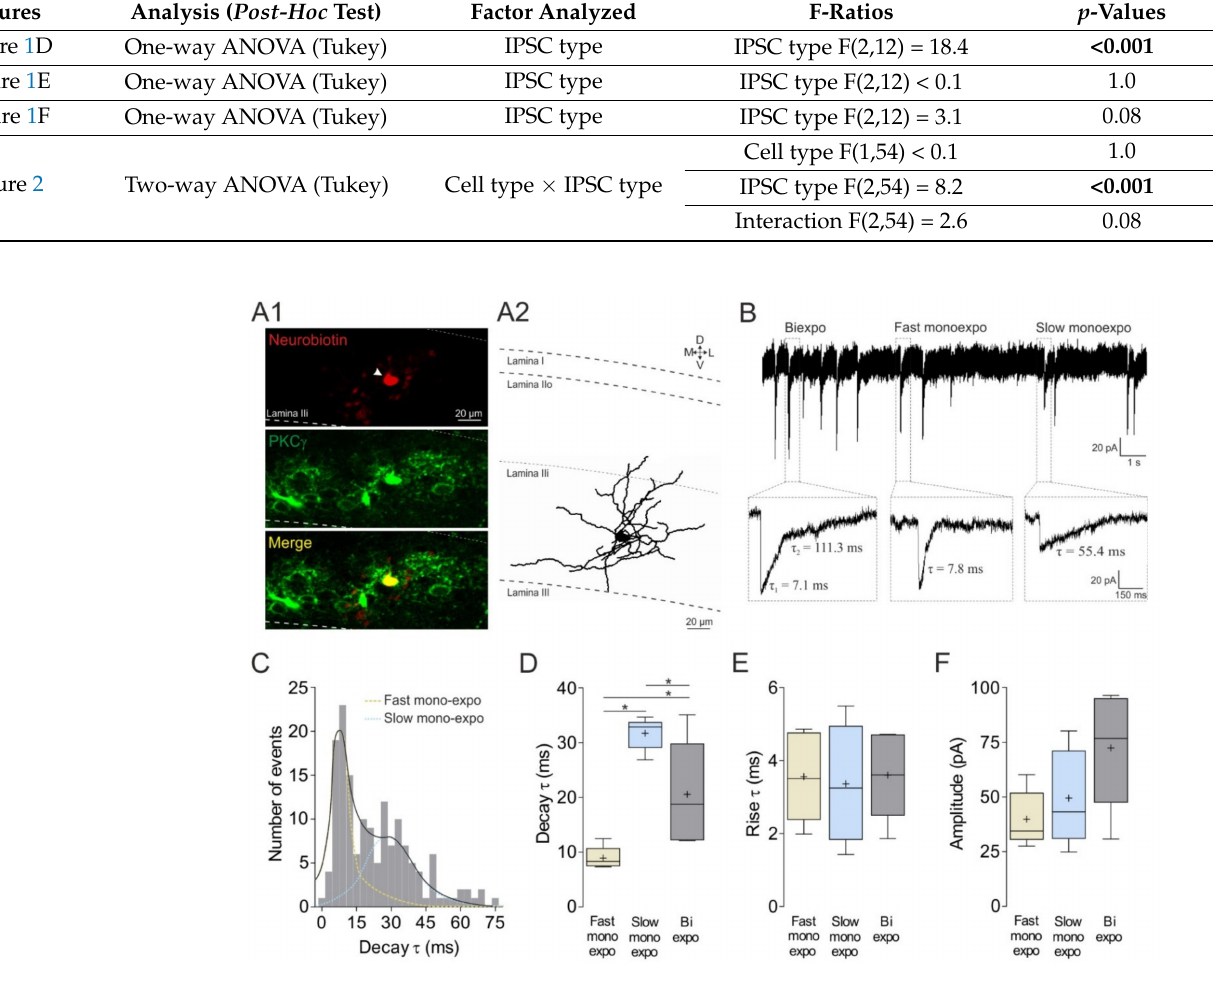
Figure 1. Functional properties of mIPSCs recorded from lamina II i PKC γ + interneurons. ( A ) PKC γ + neurobiotin-filled interneuron. Confocal images showing the neurobiotin labeling of a recorded neuron (red, arrowhead) that colocalized with the PKC γ immunostaining (green; ( A1 )). Immuno- labeling was performed in parasagittal slices (350 µ m thick). Representative neuronal reconstruction showing the neuritic arborization of recorded PKC γ + interneuron ( A2 ). M, medial; L lateral; D,